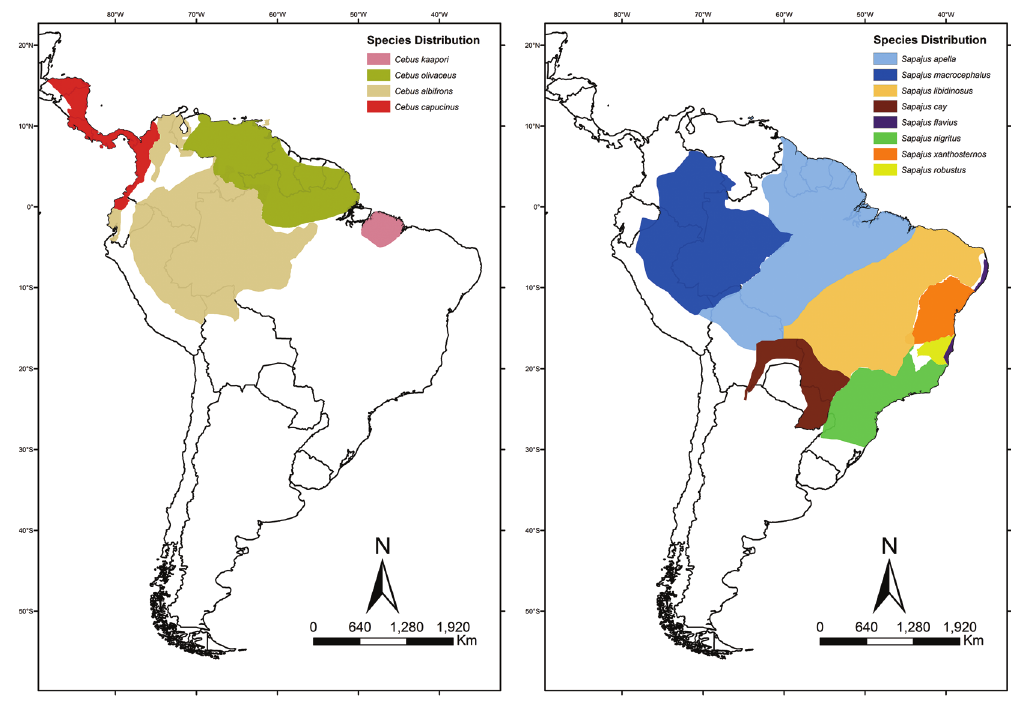
Figure 1 - Geographical distribution of robust ( Sapajus ) and gracile ( Cebus ) capuchins species. Map constructed based on information provided by Silva Jr (2001), Lynch Alfaro et al. (2012), and IUCN